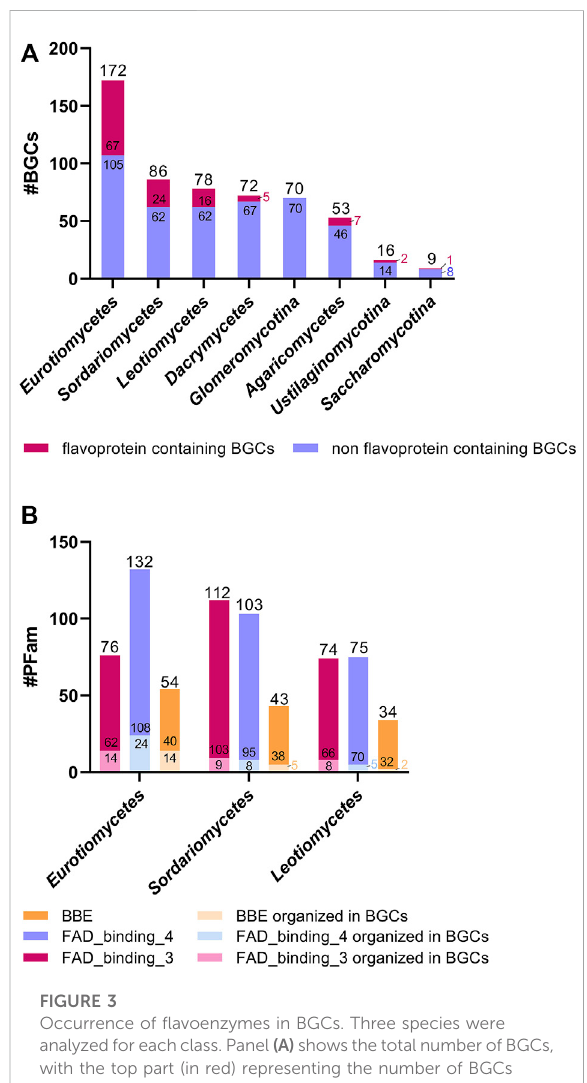
FIGURE 3 Occurrence of fl avoenzymes in BGCs. Three species were analyzedfor eachclass.Panel (A) shows thetotalnumberofBGCs, with the top part (in red) representing the number of BGCs containing at least one fl avoenzyme. Panel (B) shows the distribution of the three most common families of fl avoenzymes, FAD_binding_3, FAD_binding_4, and BBE, in Eurotiomycetes, Sordariomycetes, and Leotiomycetes. The analysis is based on the data compiled in Supplementary Table